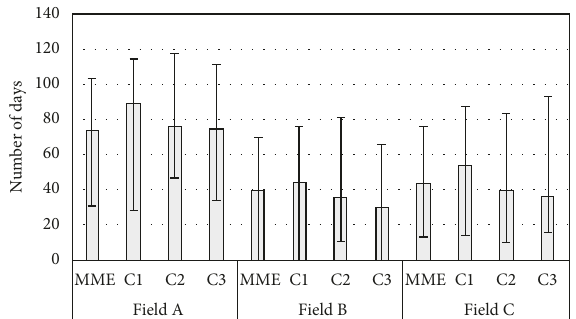
Figure 8: Simulated ski season duration (see Section 3.3 for details) for future climate. Error bars indicate ranges of interannual